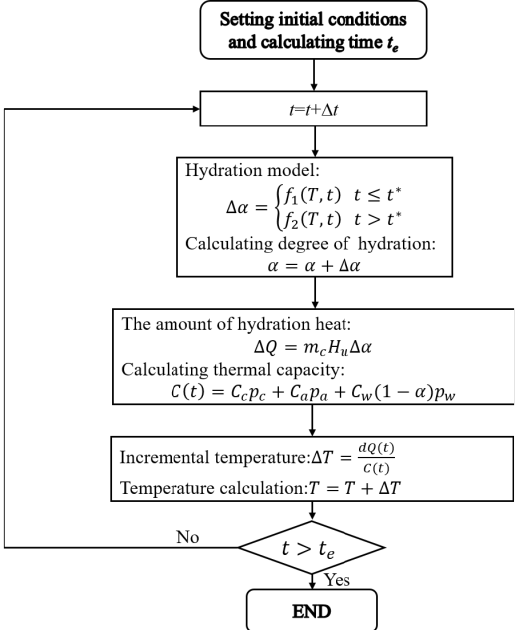
Figure 7. The flow chart of numerical simulation process.